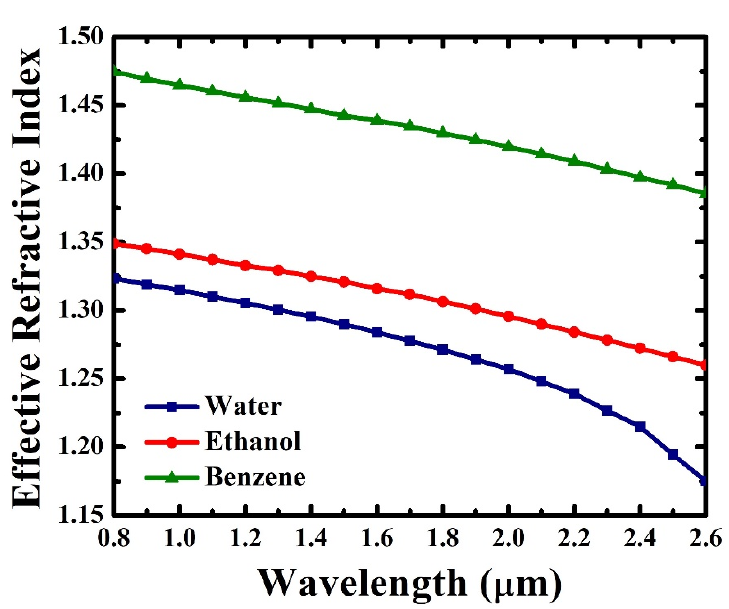
Figure 4. Effective refractive index of the proposed design against operating wavelength for water, ethanol and benzene.